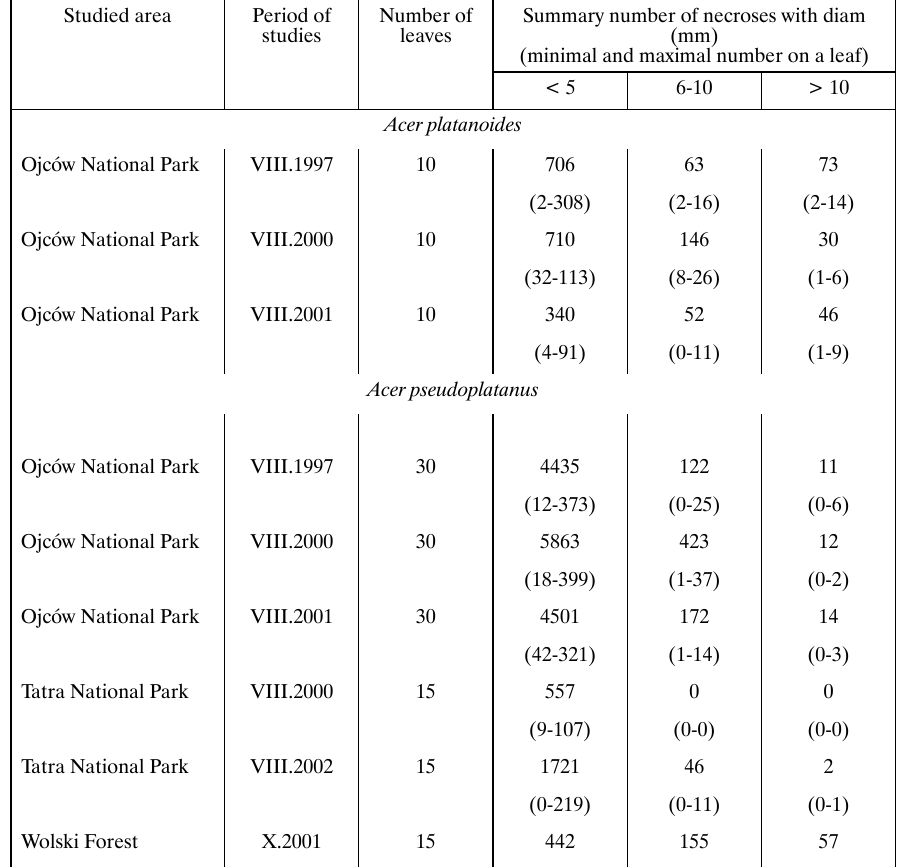
Numbers and size ranges of lesions caused by Cristulariella depraedans on leaves of Acer platanoides and A. pseudoplatanus at different periods of study Studied area Period of Number of Summary number of necroses with diam studies leaves (mm) (minimal and maximal number on a leaf) < 5 6-10 > 10 Acer